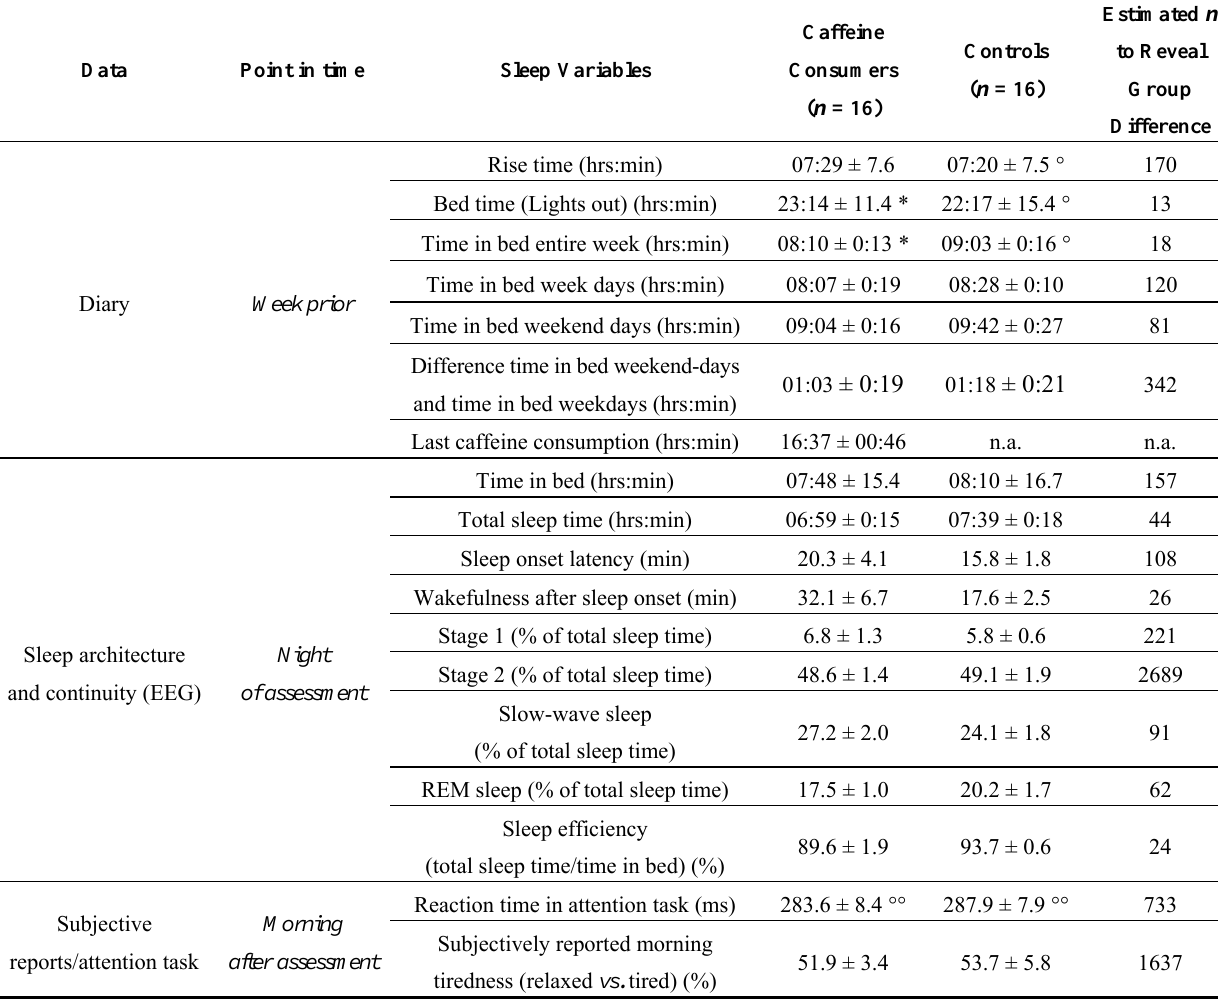
Table 2. Sleep diary, architecture, continuity, subjective reports and attention